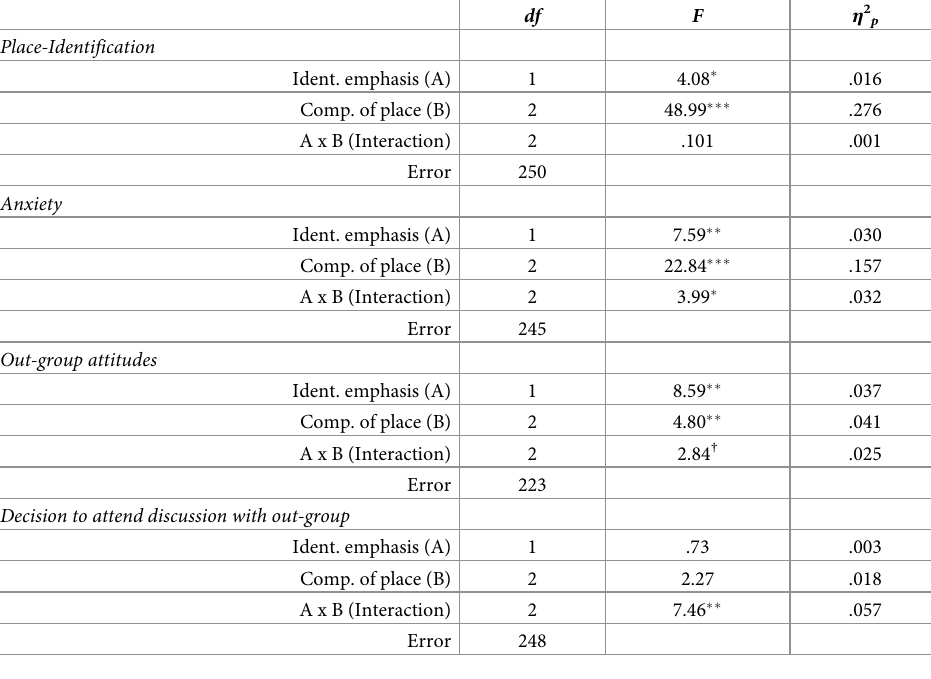
Table 7. Identity-emphasis x group representation analysis of variance for outcome variables (Study 4a). df F η 2